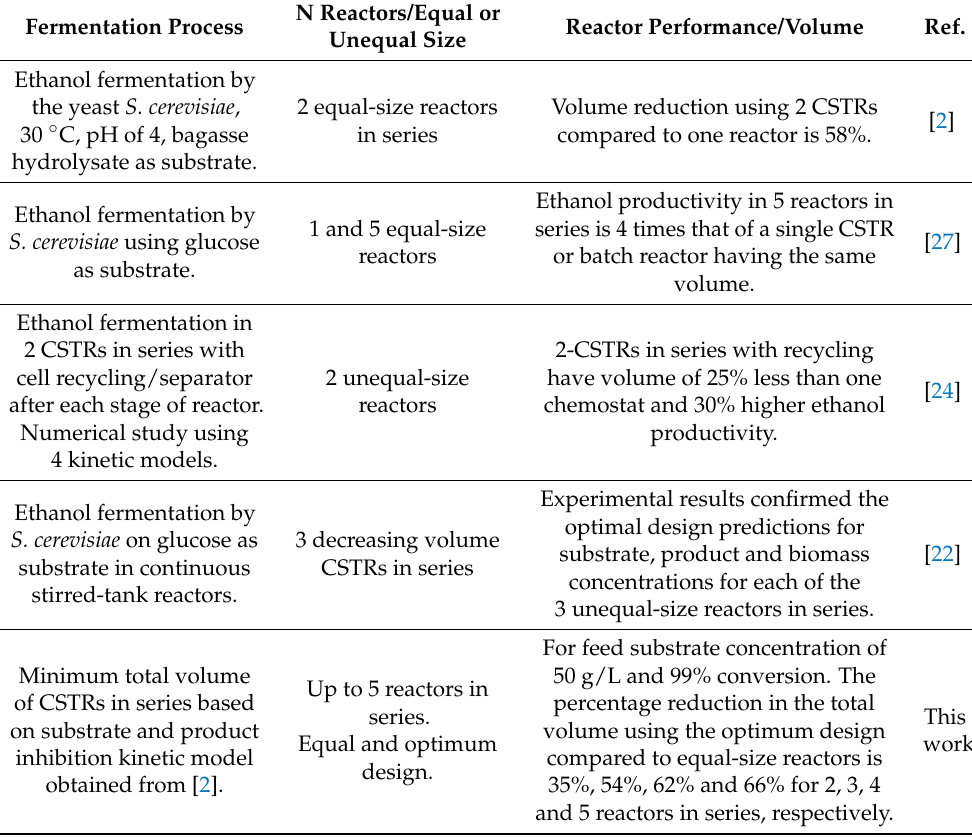
Table 2. Comparison of the current work simulation results with the